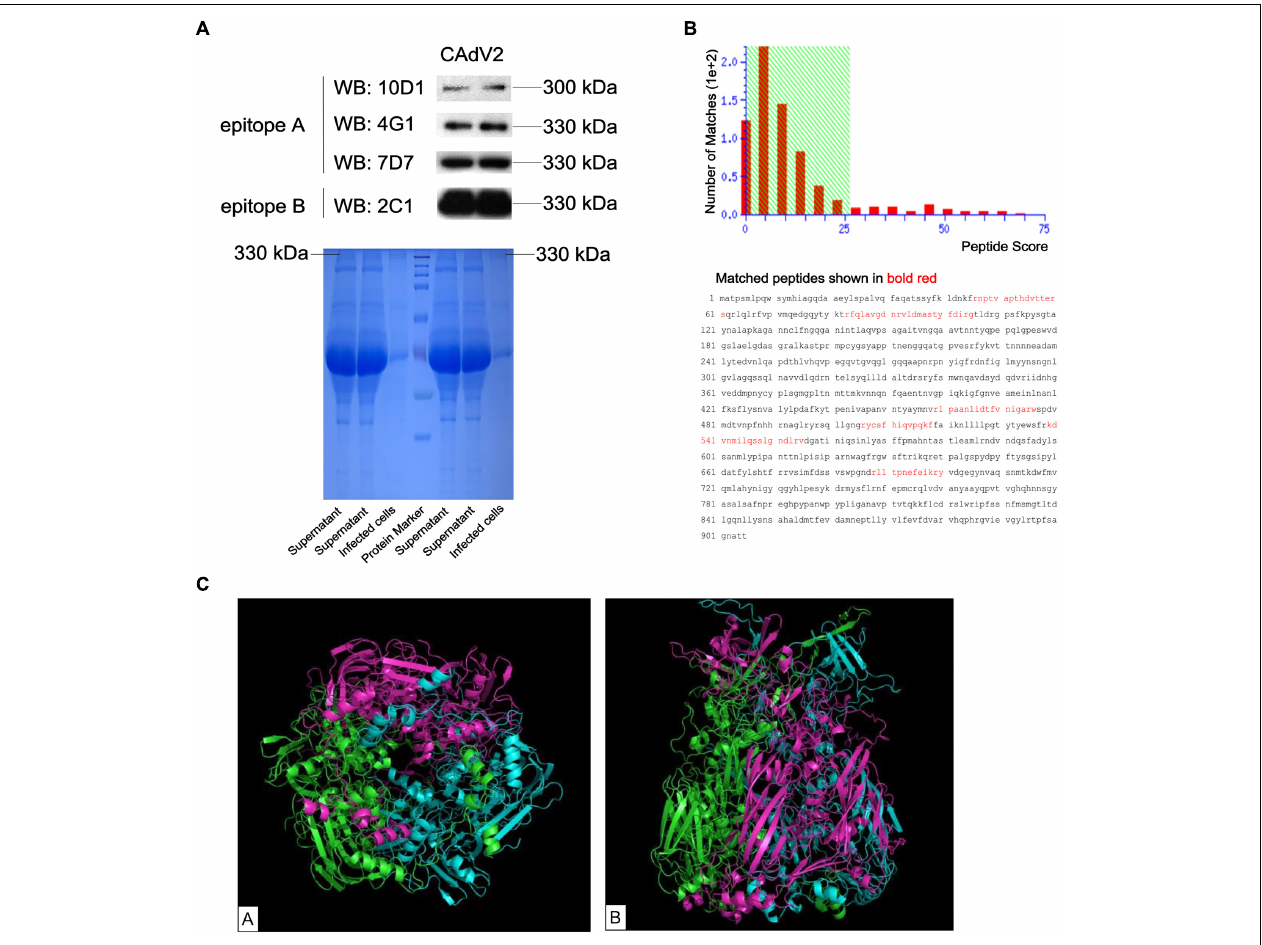
FIGURE 2 | Identification of the CAdV-2 protein that reacted with mAbs. (A) Supernatant from CAdV-2-infected MDCK cells were subjected to western blot analysis using four mAbs (upper); Supernatant and infected cell lysates were subjected to SDS-PAGE (lower). (B) MALDI-TOF-MS results of the proteins identified in bands that reacted with the four mAbs. Protein scores that were greater than 26 were significant ( p < 0.05). (C) Predicted 3D structure of the CAdV-2 hexon protein by the SWISS-MODEL online server; A, Bottom view of 3D structure; B, side view of 3D structure; different colors represent each monomer of the trimeric hexon protein.